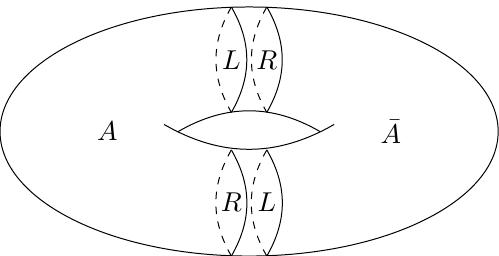
Figure 11 . Geometric entanglement entropy in Chern-Simons theory is equivalent to left-right entanglement entropy in the WZW model. L and R in the diagram represents left and right moving chiralities for the WZW